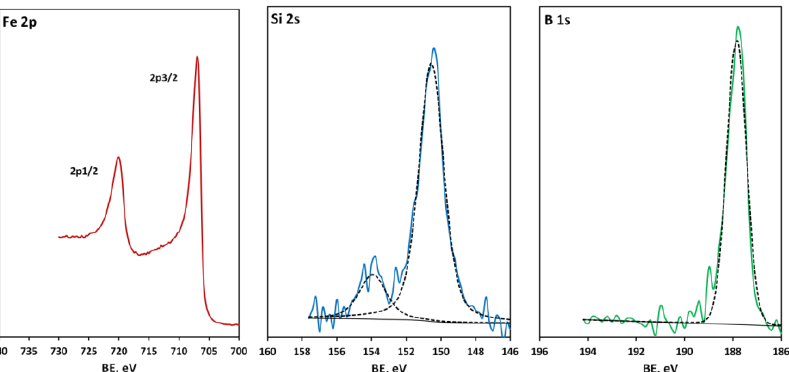
Figure 6. Fe 2p, Si 2s and B 1s spectra of a metglas-on-silicon sample produced at the third stage of the technology improvement. The experimental Si 2s and B 1s spectra (solid colour lines) were fitted using individual bands (black dashed lines). The experimental Fe 2p spectrum (red line) corresponds to metallic iron without an oxidized component.